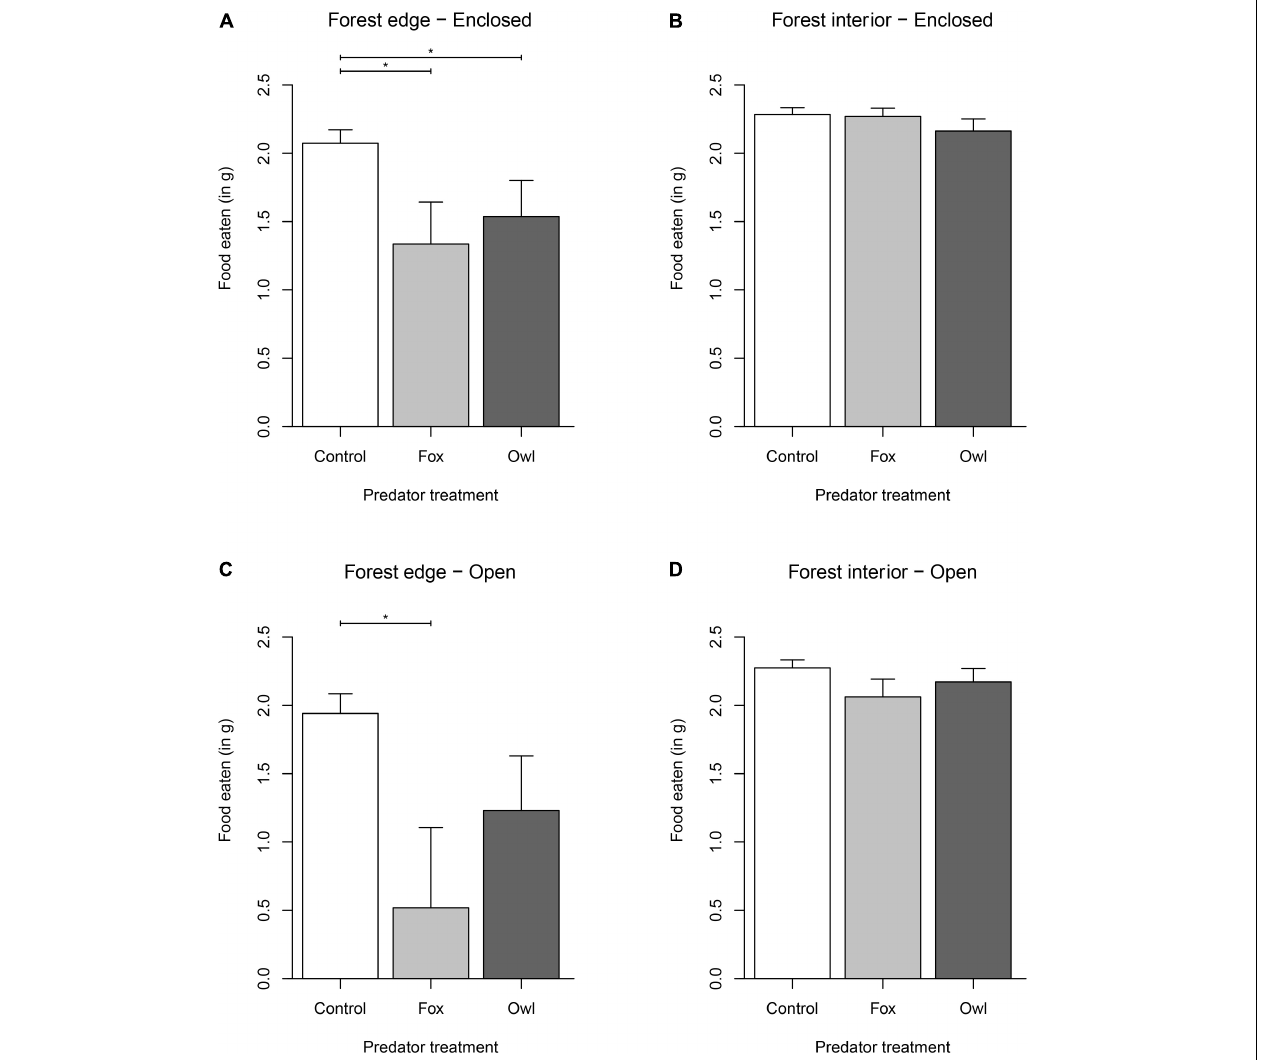
FIGURE 1 | Effect of habitat [forest edge (A–C) vs. forest interior (B–D) ], refuge [open (C,D) vs. enclosed (A,B) ], and treatment [control (white) vs. fox (light gray) vs. owl (dark gray)] on the amount of food eaten (2.5 g – GUD) by free-living white-footed mice. Upper 95% confidence interval is shown as whiskers. Asterisks indicate significant differences ( p < 0.05) among